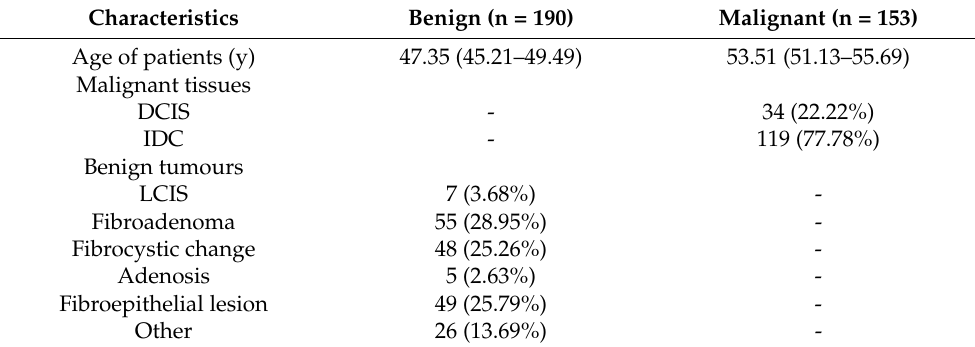
Table 2. Patient and image